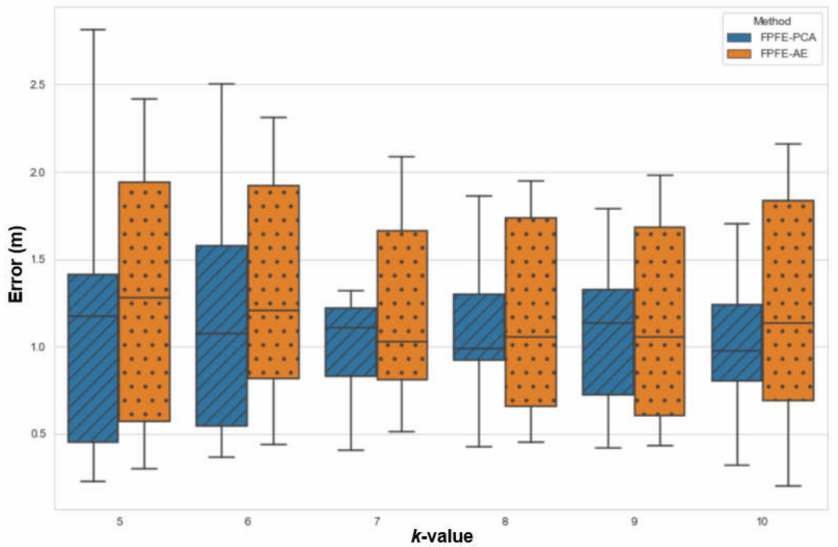
Figure 11. The localization error box and whisker plots of FPFE with 54 grid RPs for k RP candidates, where k = 5, 6, 7, 8, 9, and